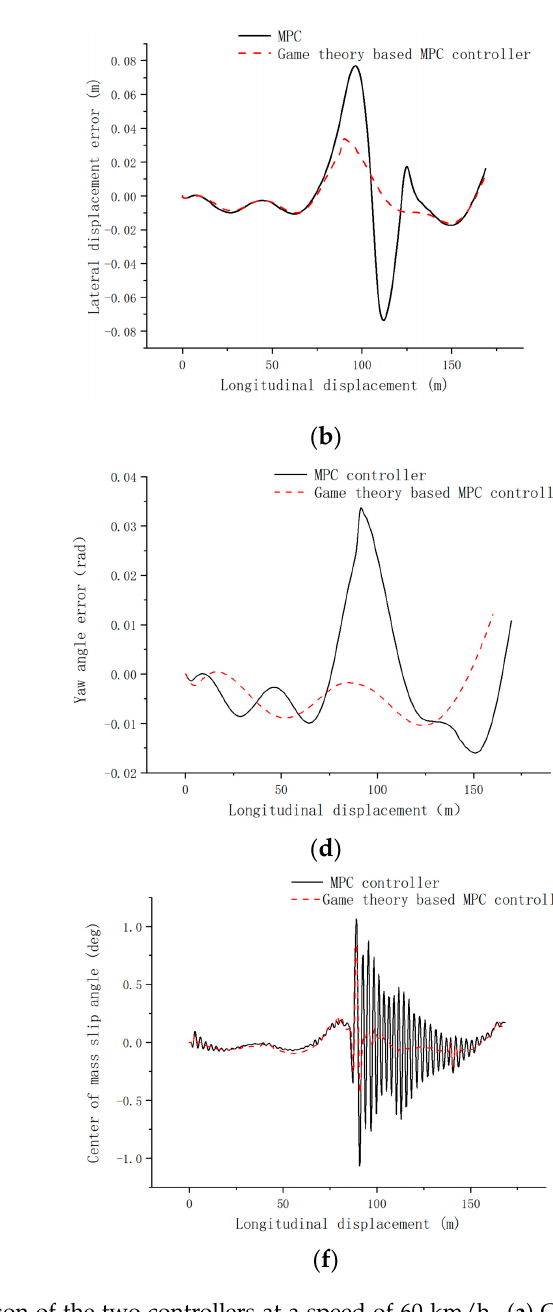
Figure 6. Simulation comparison of the two controllers at a speed of 60 km/h. ( a ) Comparative diagram of lateral displacement; ( b ) comparative diagram of lateral error; ( c ) comparative diagram of yaw; ( d ) comparative diagram of yaw angle error; ( e ) comparative diagram of lateral acceleration; ( f ) comparative diagram of center of mass slip